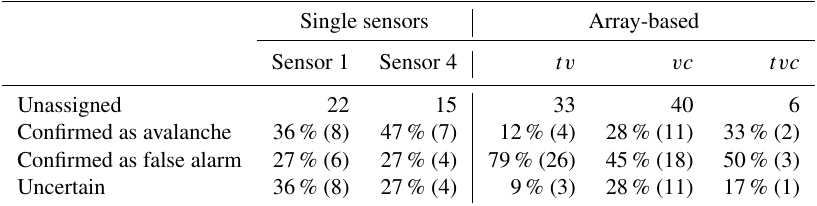
Table 4. Results of the reanalysis of the detections not covered by the test data set. Left side of the table shows the results of the reanalysis of two single sensors, while the right side shows the results of the array-based classification. For the single sensors a minimum duration for the events of t min = 12s was taken into account. The voting-based processing steps analyzed are minimum number of votes ( v ), minimum duration ( t ) and coherence ( c